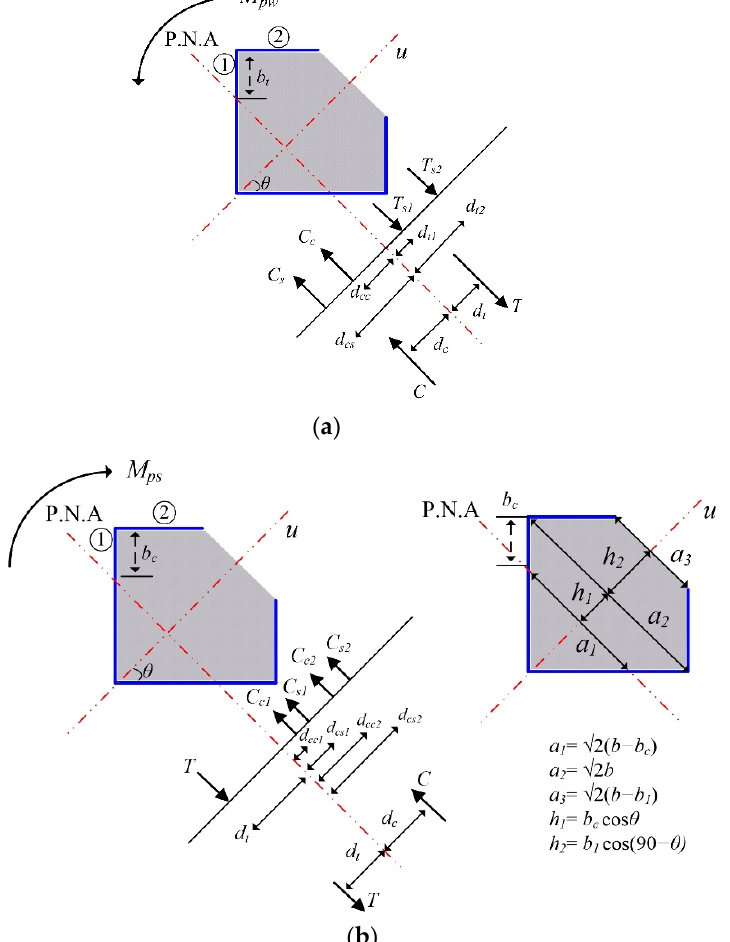
Figure 16. Force distributions in the proposed column section under plastic moment: ( a ) for weak axis; ( b ) for strong axis.